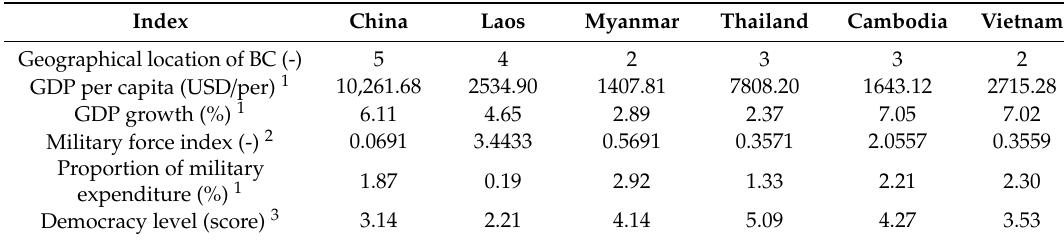
Table 6. Asymmetric power (AP) of basin countries in